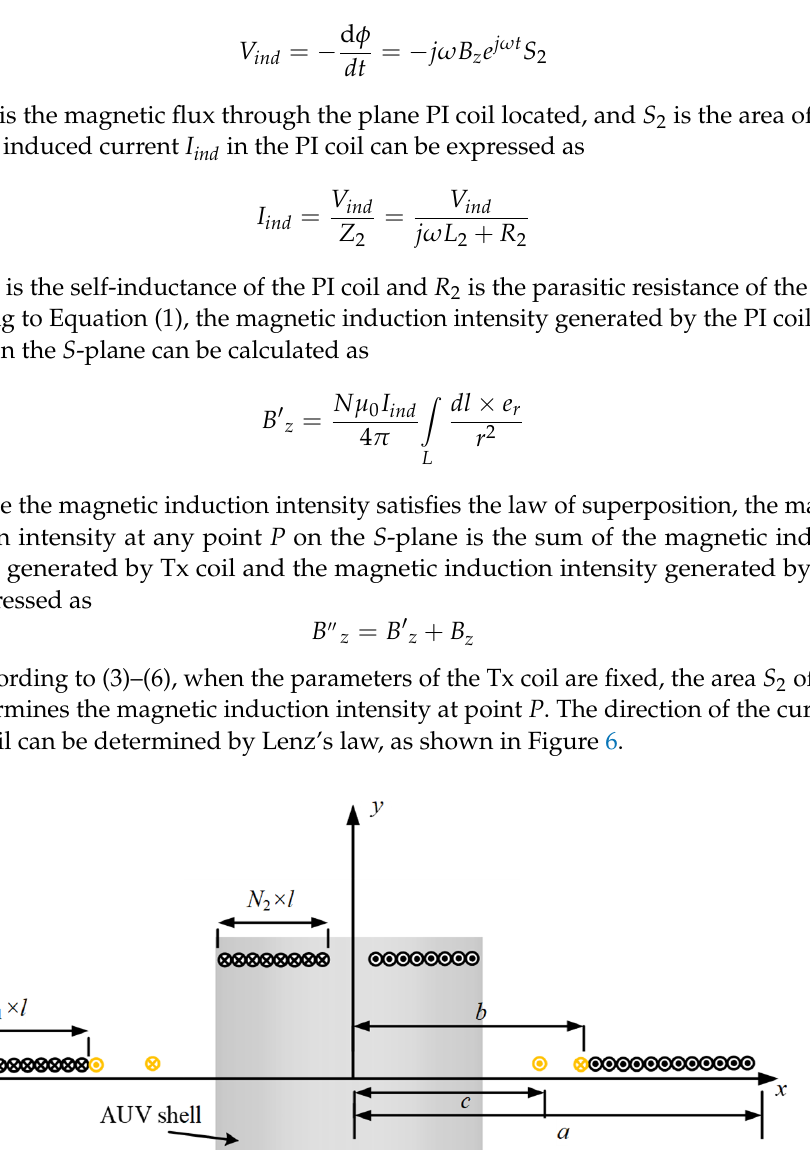
( b ) Figure 7. Magnetic induction intensity distribution varying with PI coil size: ( a ) When the outside diameter of PI coil changes; ( b ) When the inner diameter of PI coil changes. The above discussion shows that the introduction of a PI coil can improve the uni- formity of the induced magnetic field distribution. The values of parameters b and c that meet the requirements can be obtained through the flowchart shown in Figure 8. It is finally determined that b = 153 mm, which is the outermost turn of the PI coil when wound tightly to the inside of the Tx coil, and the inner diameter c is selected as 130 mm. Figure 9 shows the magnetic induction intensity distribution on the S -plane when adding a PI coil and using only circular coil. −130